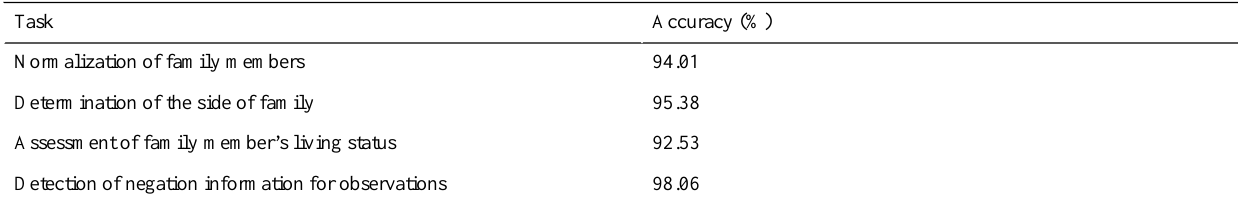
Table 6. Accuracy of attribute classification of given reference standard concepts.